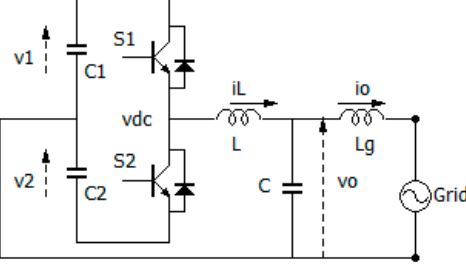
Figure 6. Inverter circuit in master mode.